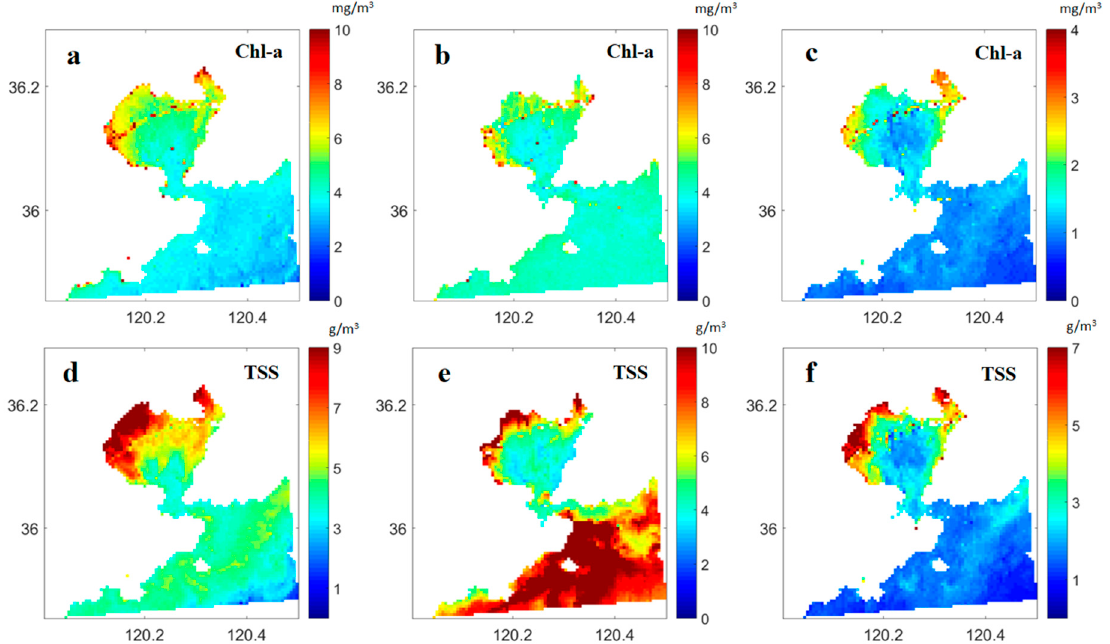
Figure 2. Distributions in JZB of concentrations of chlorophyll-a ( a – c ) and total suspended sediment ( d – f ) for each GOCI pixel on 13 September, 2017 ( a , d ), 4 November, 2017 ( b , e ) and 9 March, 2018 ( c , f ).